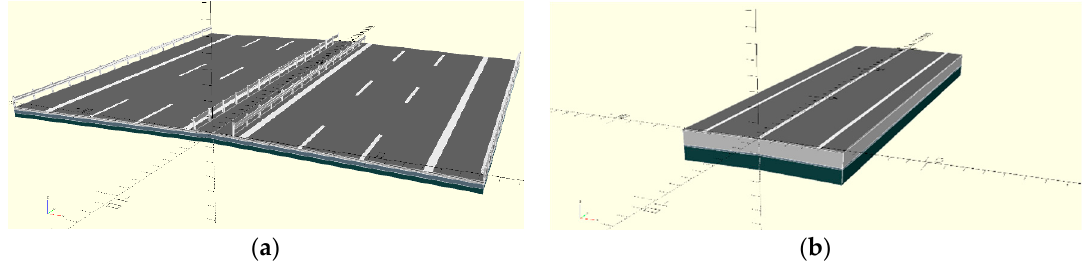
Figure 3. Road Type: ( a ) Freeway: Type A; ( b ) Minor arterial: Type C.